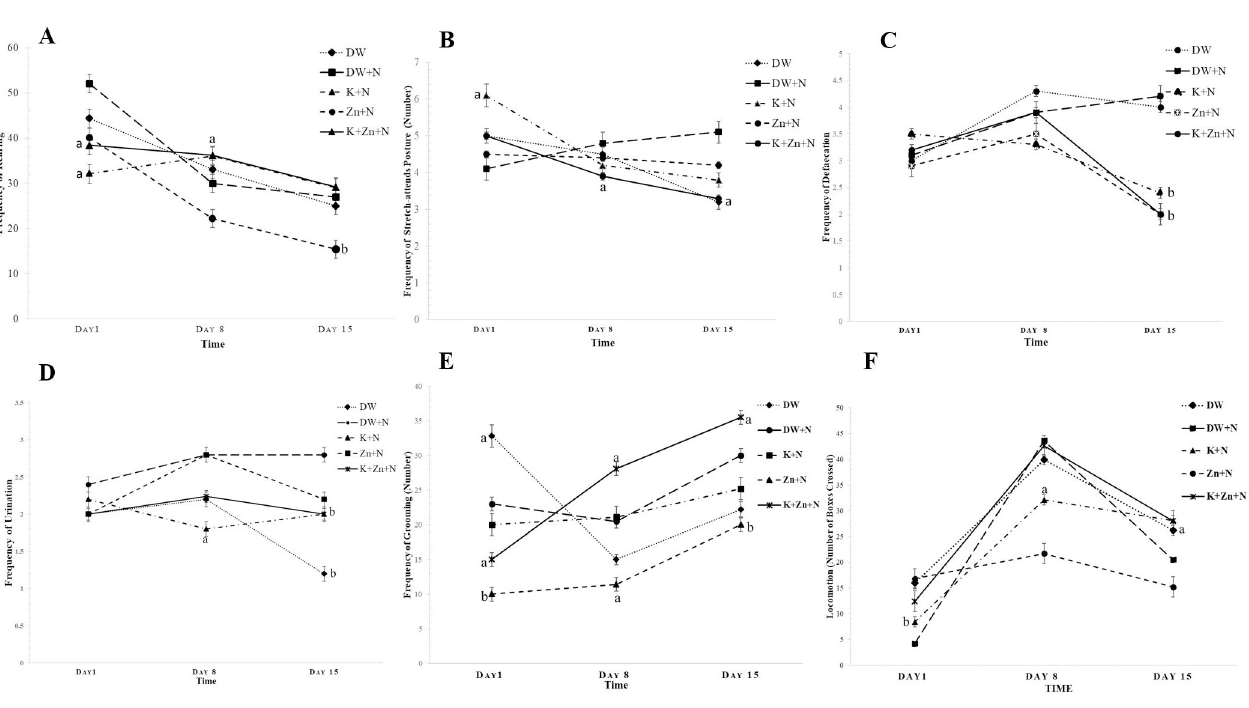
Fig 2. Effect of kaempferol and zinc on open-field parameters in Wistar rats exposed to noise stress (Mean ± SEM, n = 6). Individual rats were placed in the box and allowed to walk freely and become familiarized with the environment for a period of 3 minutes. Thereafter and for the next 2 minutes, the number of squares crossed with all the paws by each rat was recorded. Rearing was measured by determining the frequency at which the rat stood on its hind-limbs; with the fore-paws lifted freely or leaned against the wall of the apparatus during the next 2 minutes, after the initial 3 minutes of habitation. The frequency of grooming, the number of feces and puddles of urine voided were observed and recorded using a camera. A) Effect of kaempferol and zinc on the frequency of rearing. B) Effect of kaempferol and zinc on the frequency of stretch-attends postures (number). C) Effect of kaempferol and zinc on the frequency of defecation. D) Effect of kaempferol and zinc on the frequency of urination E) Effect of kaempferol and zinc on the frequency of grooming. F) Effect of kaempferol and zinc on locomotion. a P < 0.05, b P < 0.01, is significantly different compared to control group (DW+N). DW, Deionized water; K, Kaempferol; Zn, Zinc gluconate; N,